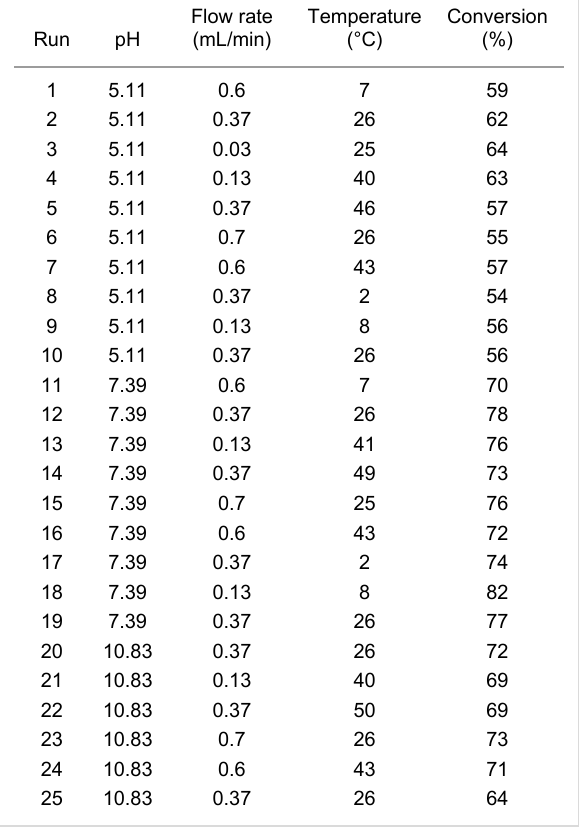
Table 1: Data showing conversions attained at different reaction condi-